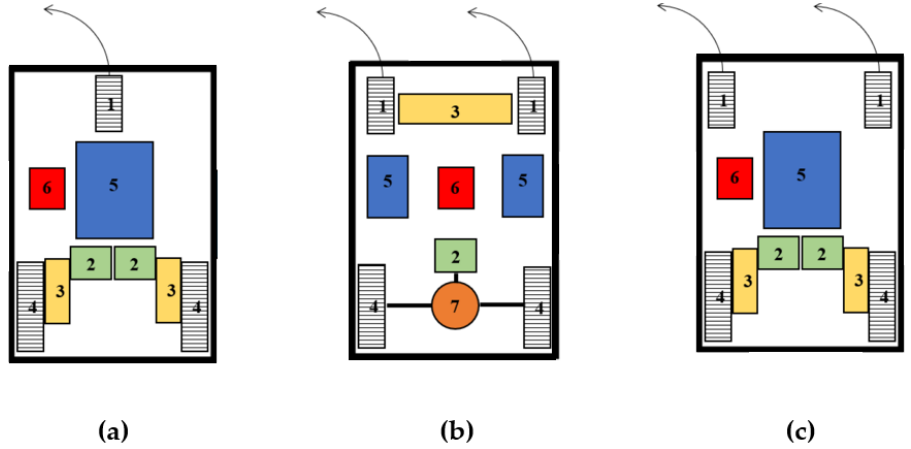
Figure 1. Scheme of variant I ( a ), variant II ( b ), variant III ( c ) (Legend: 1 — steering wheel, 2 — electric motor, 3 — distribution mechanism, 4 — wheel drive, 5 — accumulators, 6 — control unit, 7 — transmis- motor, 3—distribution mechanism, 4—wheel drive, 5—accumulators, 6—control unit, 7—transmission sion with differential). with